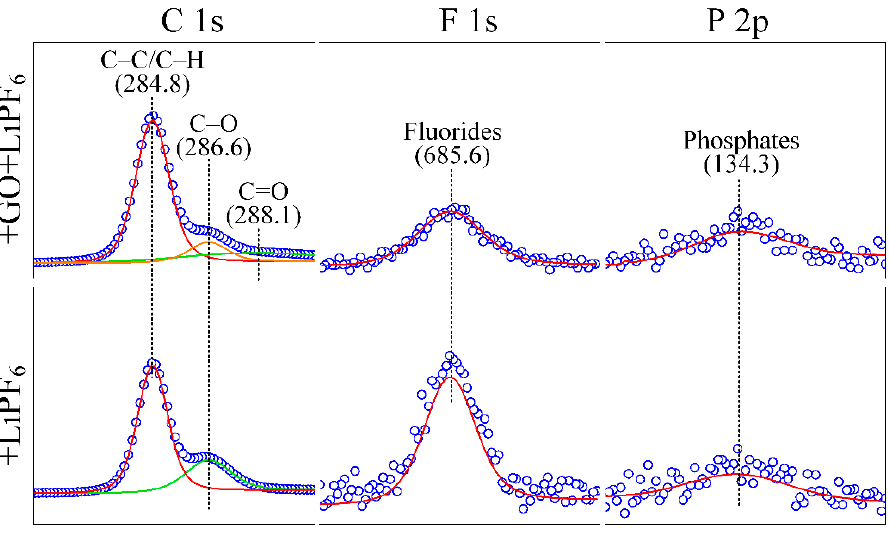
Figure 7. ( a , b ) HRTEM images of GO adsorption layer on worn surfaces. ( c , d ) Raman spectra of GO adsorption layer on worn areas. To further study the synergy effect of LiPF 6 and GO in DEG(aq), the following test was performed. Firstly, a conventional friction test was carried out by using LiPF 6 − con- taining DEG(aq) as the lubricant, and the test was suspended after the COF tended to be steady with a COF value of 0.04. Then, the worn surfaces were cleaned with deionized water to remove the fluid layer and retain the tribochemical layer of LiPF 6 . Then, GO − con- taining DEG (without water) was dropped on the worn surface and the test was restarted on the same worn track. The aim of this procedure was to form the GO adsorption layer on the tribochemical layer by physical overlaying. The result showed that the COF was further reduced to 0.029 and kept steady for more than 700 s (Figure 8). The properties and functions of the tribochemical layer and GO adsorption layer formed by physical overlaying were inevitably different from that formed “in situ” by directly employing DEG(aq) + GO + LiPF 6 , which may result in a COF larger than 0.01. Despite these, the